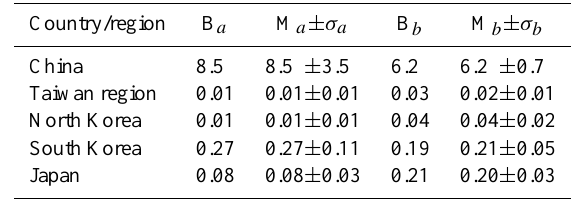
Table 6. HCFC-142b emissions (kt/yr) per country/region for the year 2008.